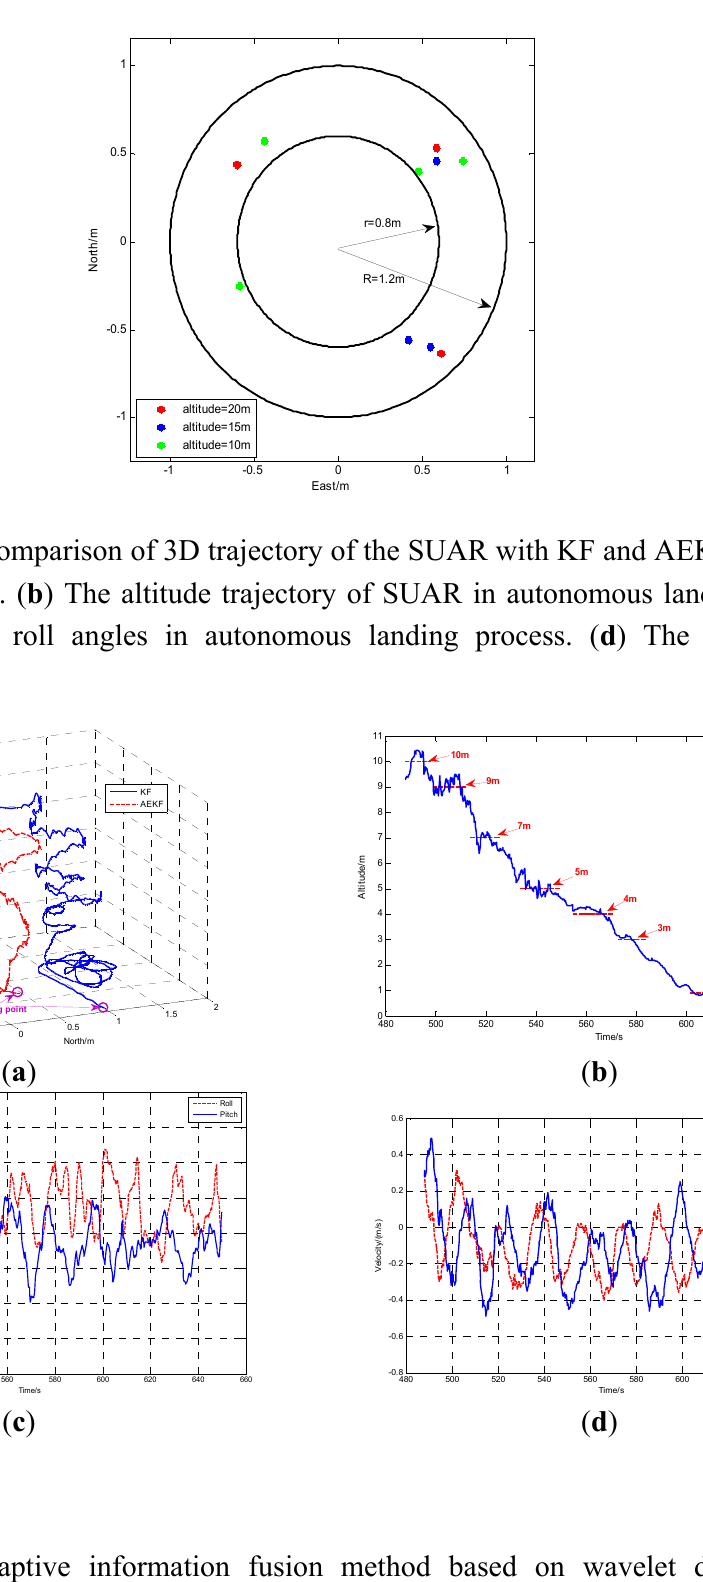
Figure 7. The result of autonomous landing tests from different altitudes.